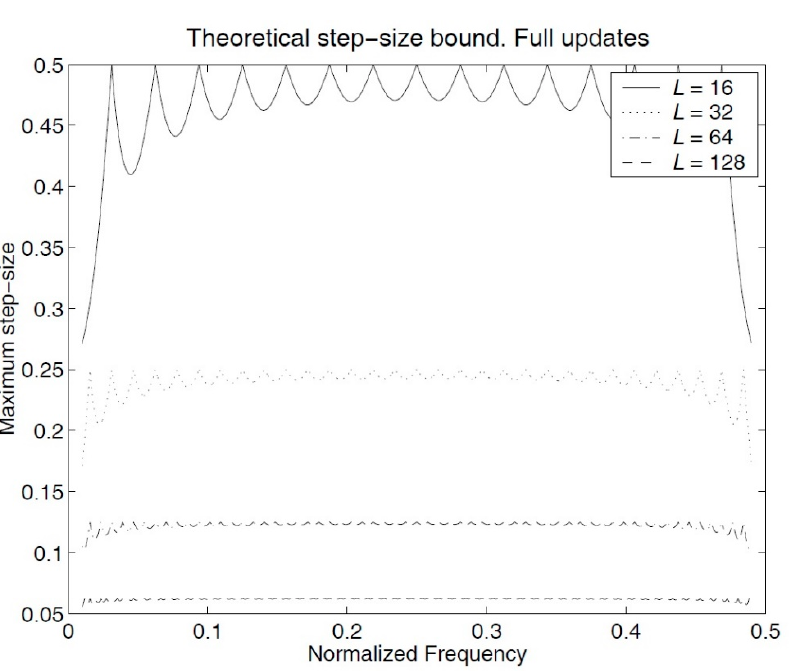
Figure A1. Step-size bound of the conventional full updates LMS algorithm for different filter lengths, L = 16, 32, 64, and 128. The input vector is a single tone whose normalized frequency varies from 0 to 0.5.